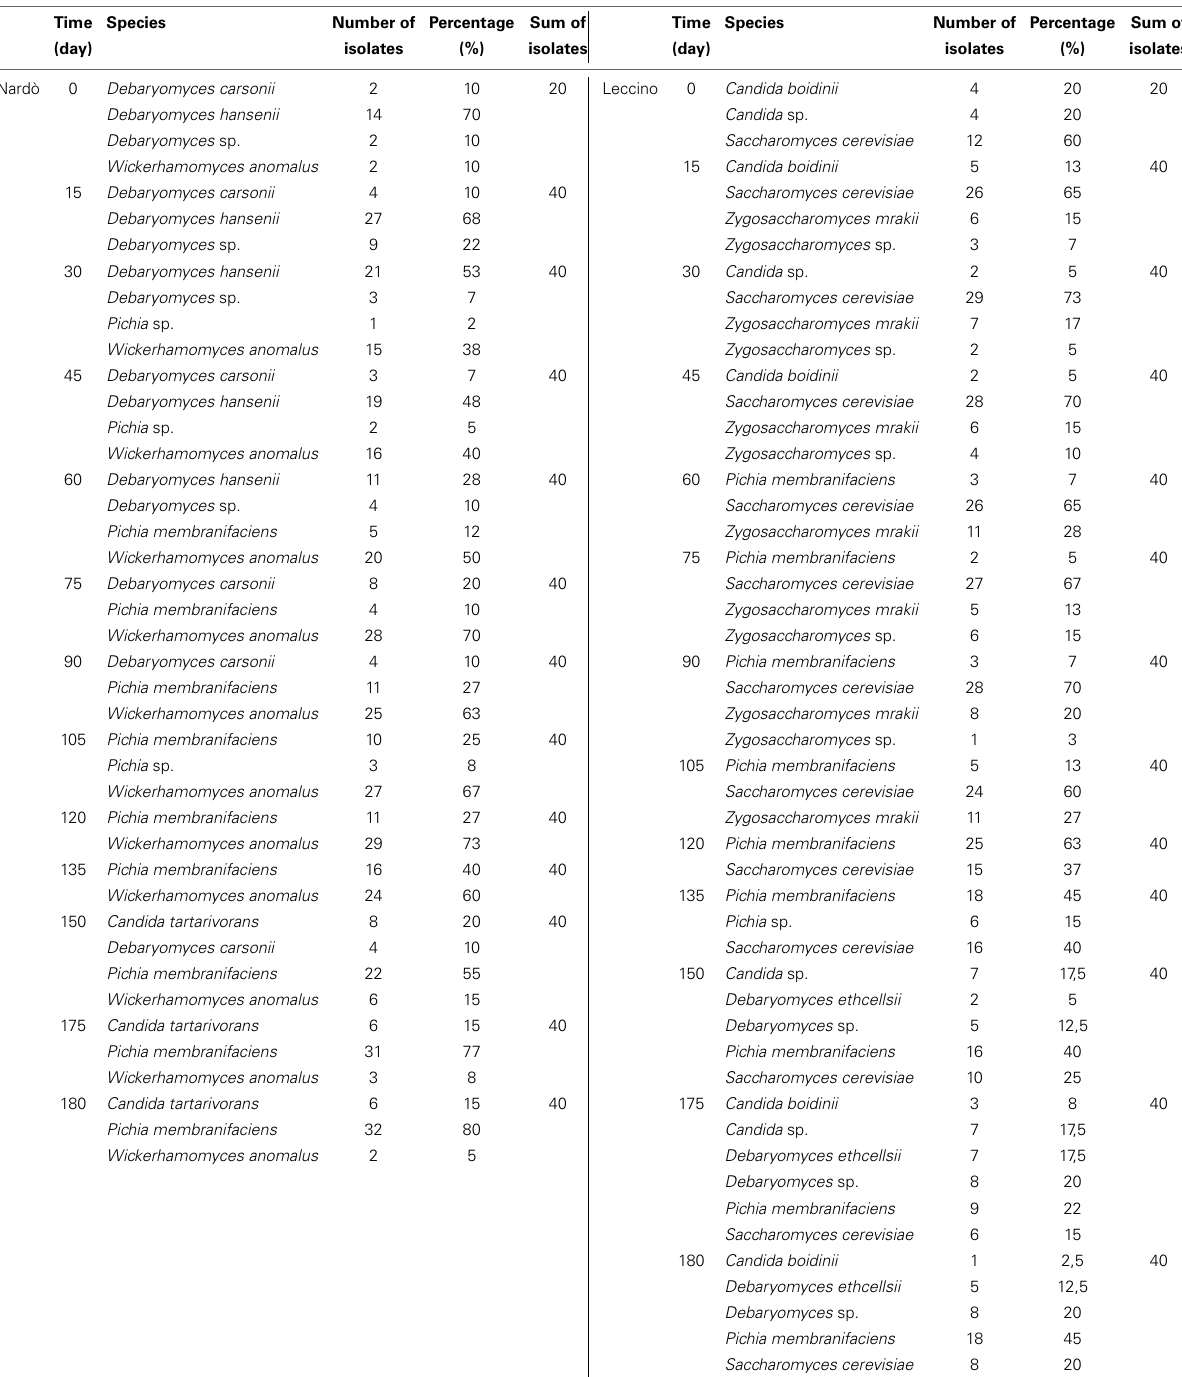
Table 1 | Yeast isolates identified during spontaneous fermentation of Cellina di Nardò and Leccino olives. Time Species Number of Percentage Sum of Time Species Number of Percentage Sum of isolates